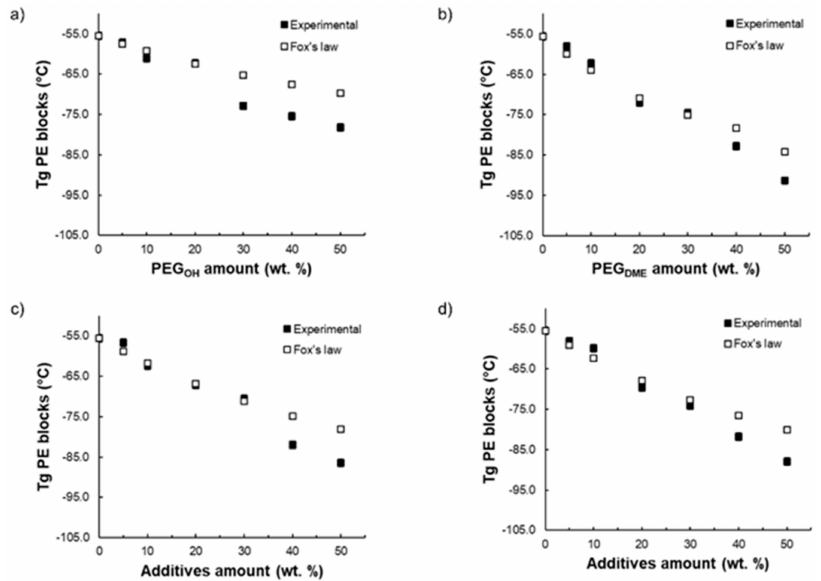
Figure 3. Comparison between the experimental T g and the theoretical T g calculated by Fox’s law as a function of the additive amount for Pebax ® /PEG OH blends ( a ), Pebax ® /PEG DME blends ( b ), Pebax ® /PEG OH /PEG DME blends with a 50/50 PEG OH /PEG DME weight ratio ( c ), and Pebax ® /PEG OH /PEG DME blends with a 37.5/62.5 PEG OH /PEG DME weight ratio ( d